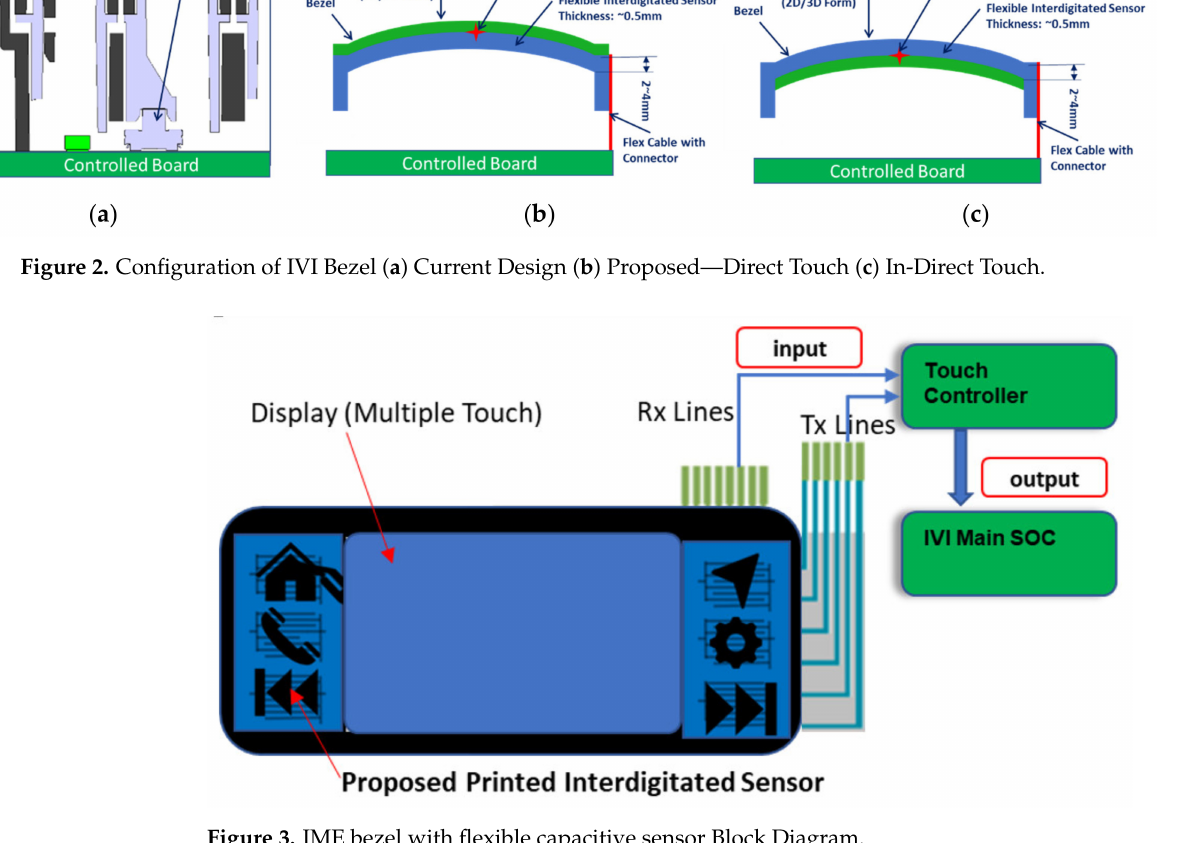
Figure 3. IME bezel with flexible capacitive sensor Block